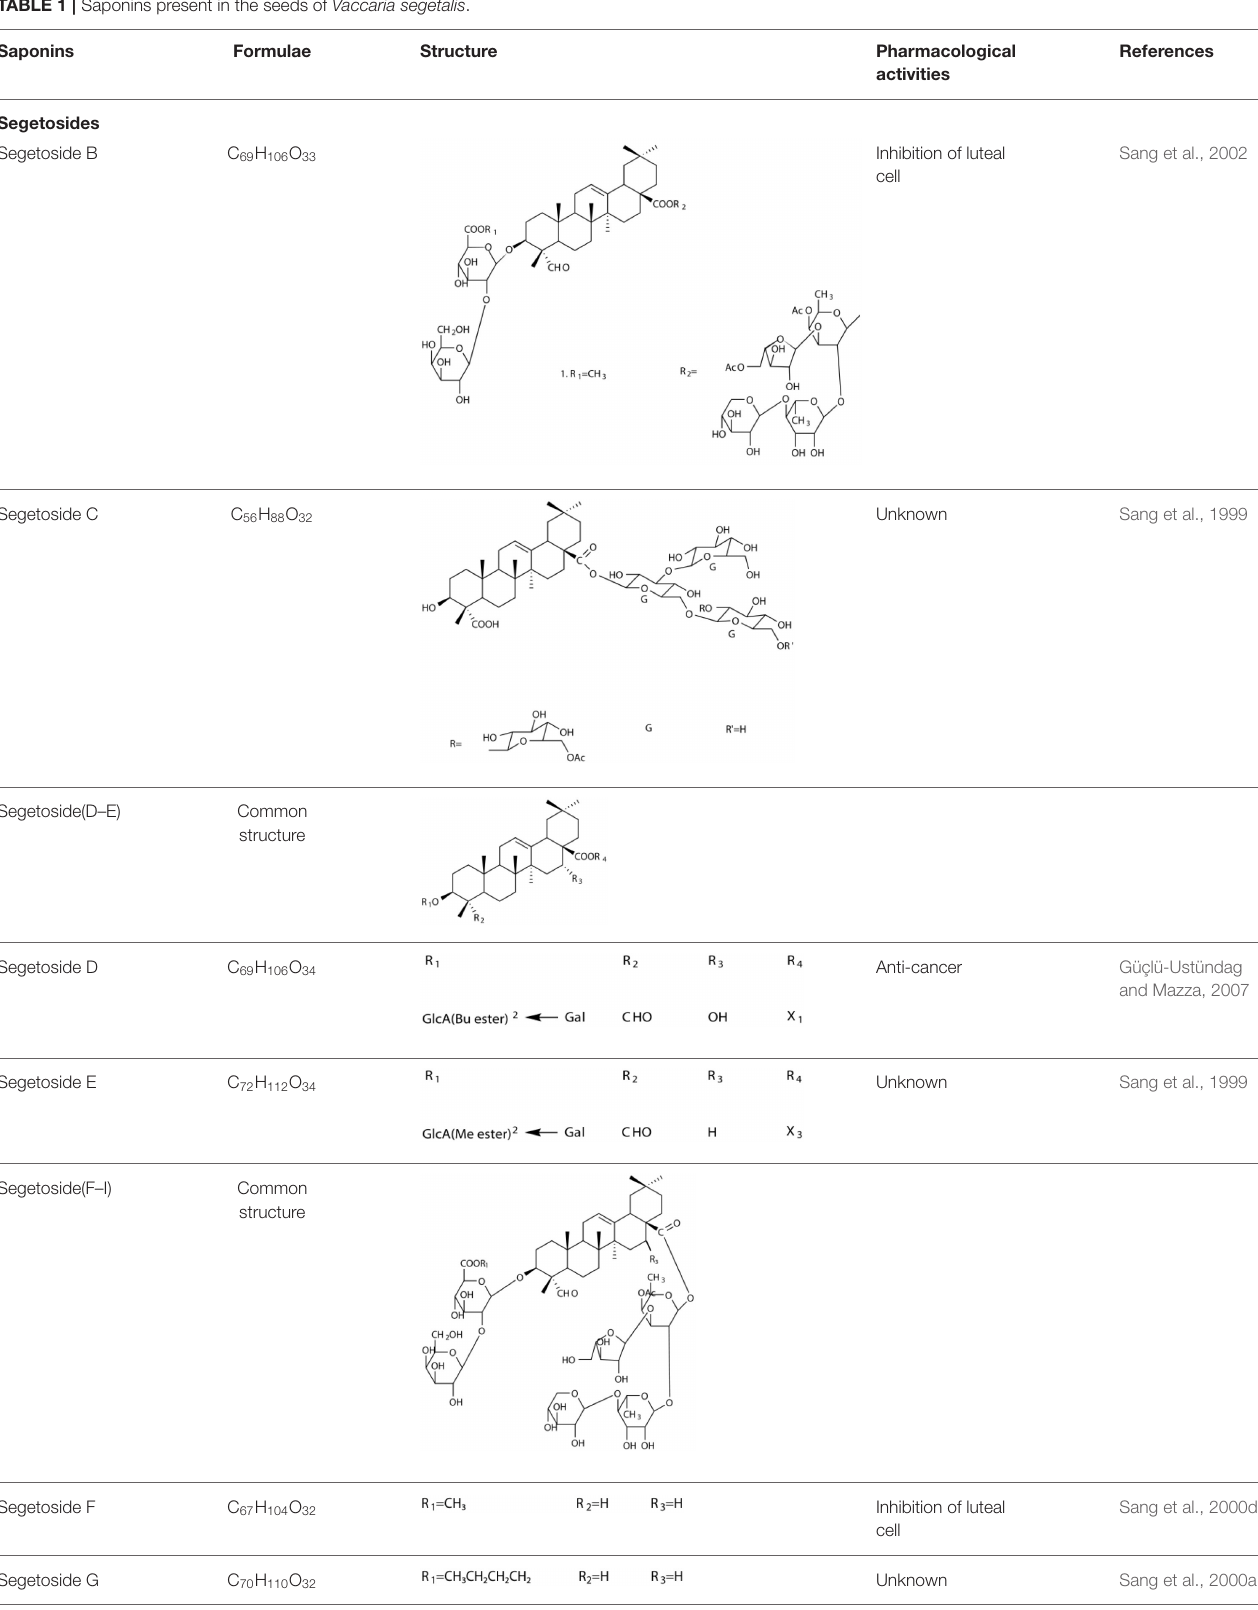
TABLE 1 | Saponins present in the seeds of Vaccaria segetalis